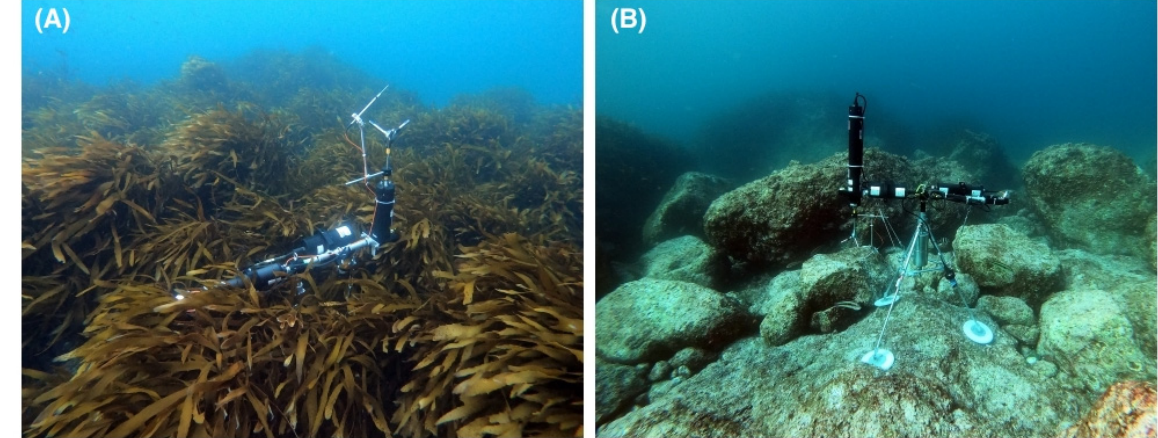
Figure 2. Pictures of AEC deployment in Kelp Bed ( A ) and Bare Rock ( B ).